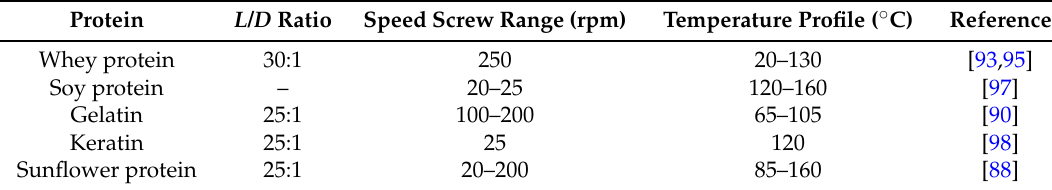
Table 2. Typical ranges of extrusion parameters in the processing of some proteins. Protein L / D Ratio Speed Screw Range